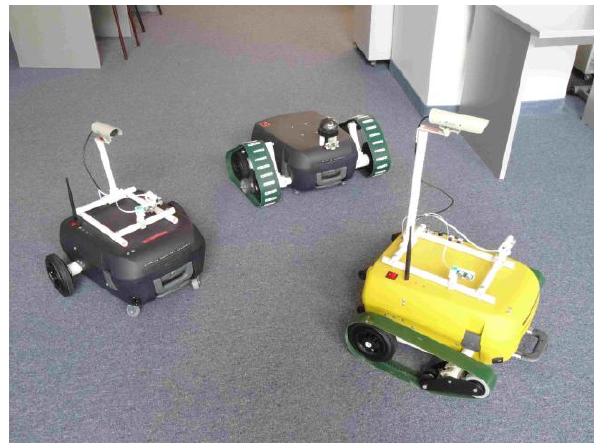
Figure1. Various mobile robots of the AMUR series of Far Eastern Federal